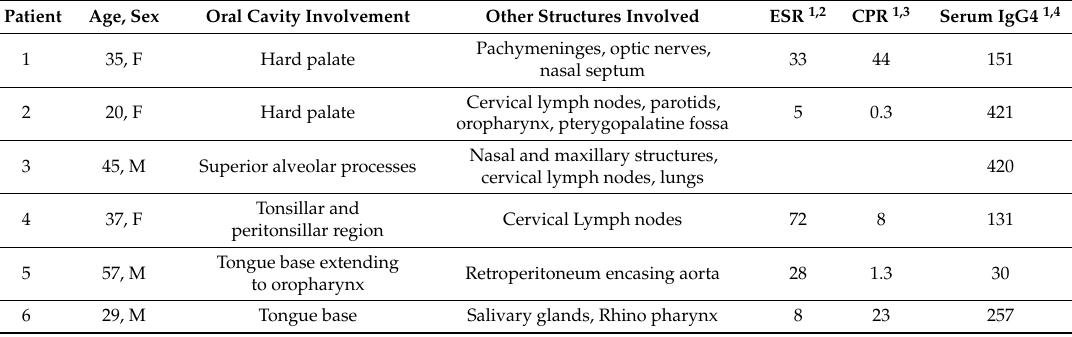
Table 1. Main demographic features, sites of lesion and serum findings.